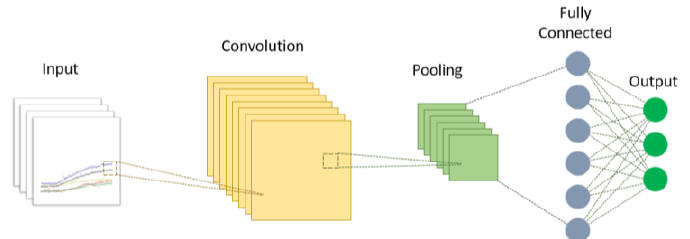
Figure 9. Convolutional Neural Network.